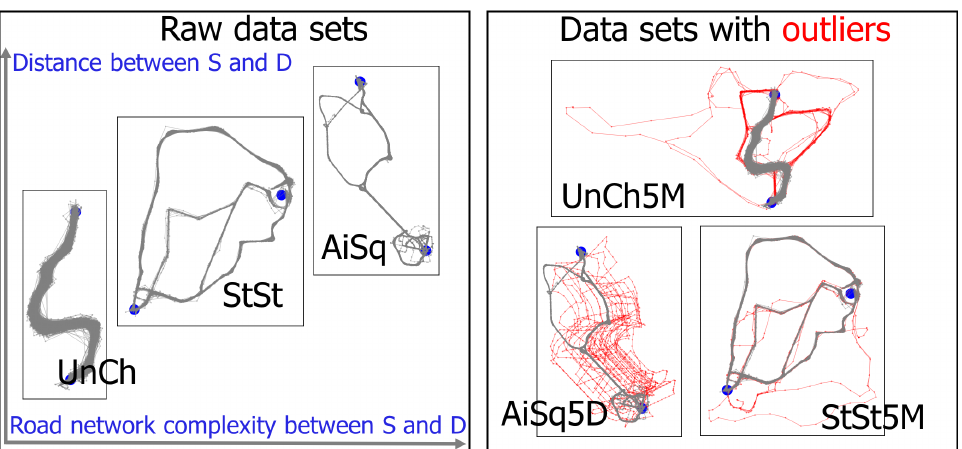
Figure 5. ( Left ) Normalities of three raw datasets with different source and destination points. ( Right ) Example of datasets with outliers. More information is reflected in Table